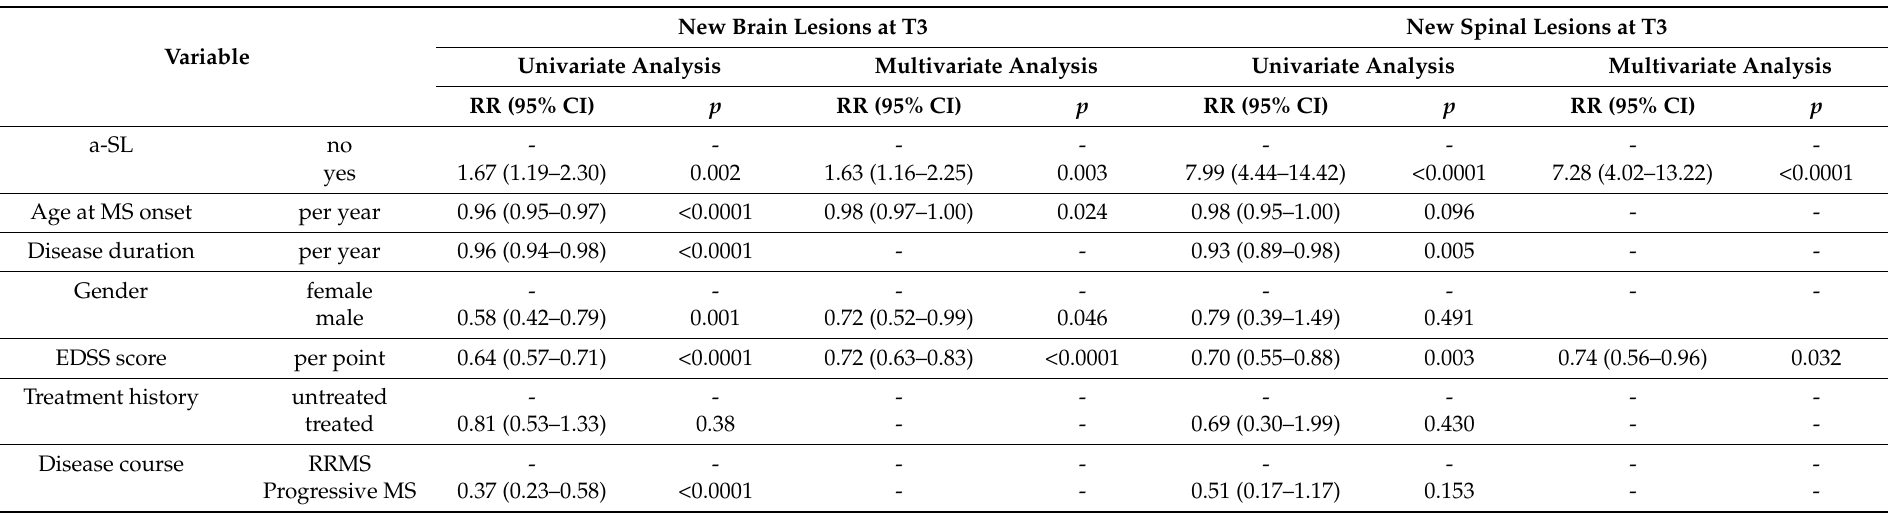
Table 3. Univariate and multivariate Poisson regression models testing variables associated with occurrence of new brain and spinal MRI lesions at T3 as compared to T2.